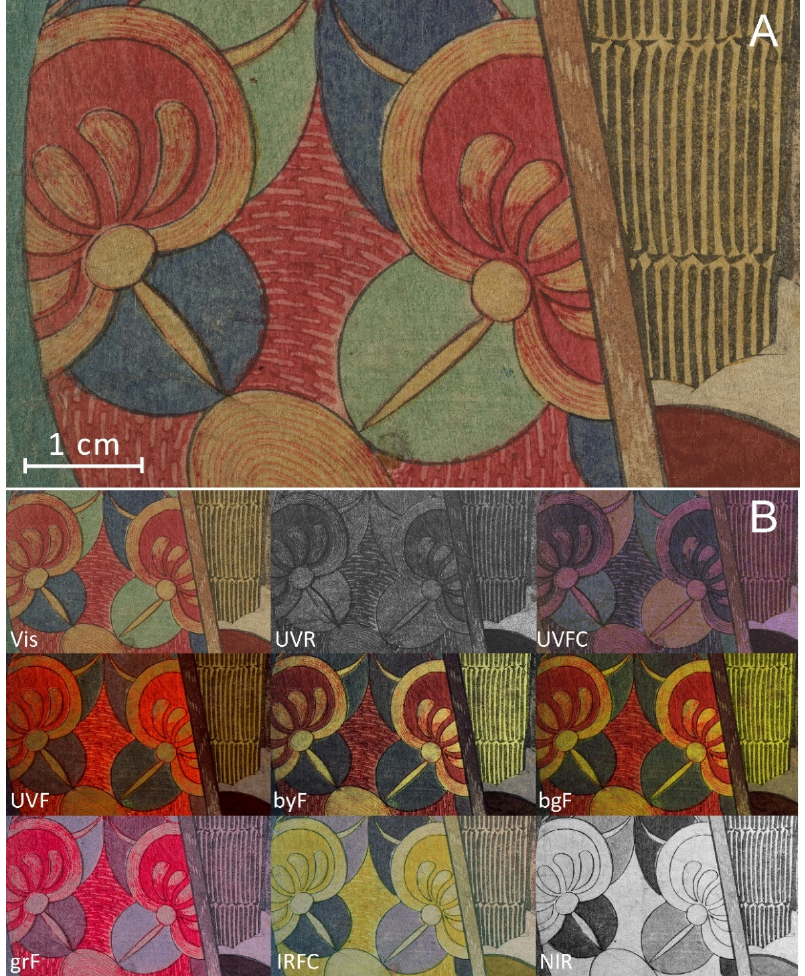
Figure 3. Detail of print 1 showing the high resolution of the acquisition ( A ) and a general view of all the multiband images ( B ).